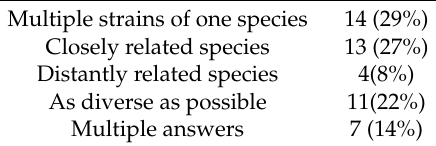
Table 3. Responses to question on the types of hosts to be used for host range